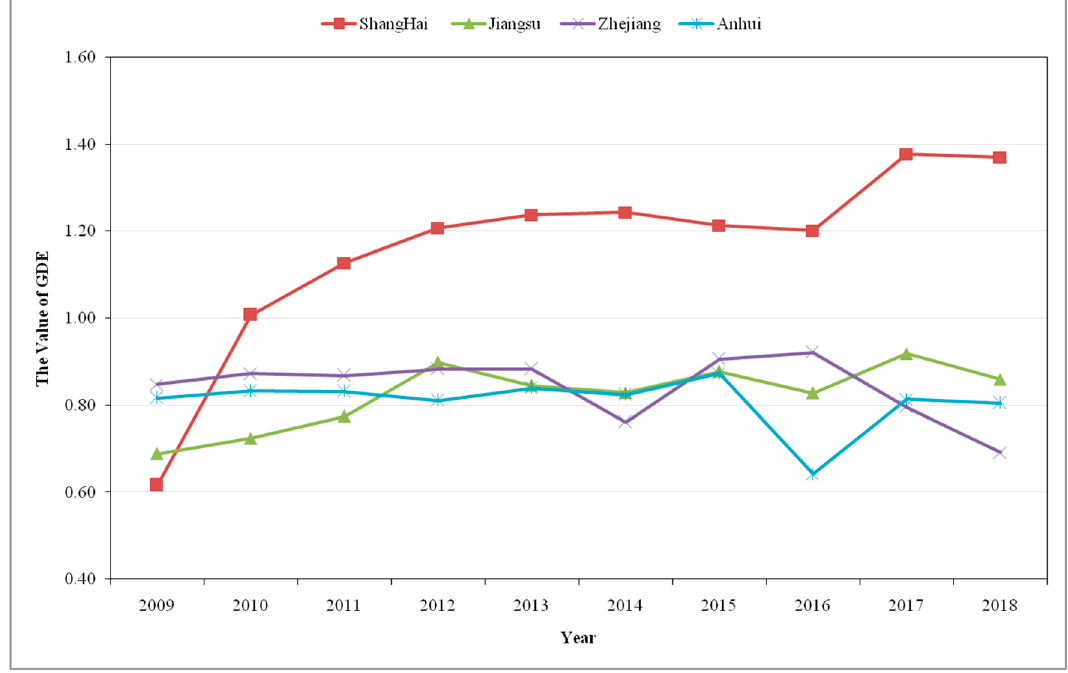
Figure 4. Average annual GDE of 4 regions in the Yangtze River Delta. Note: was once at the lowest level of 0.